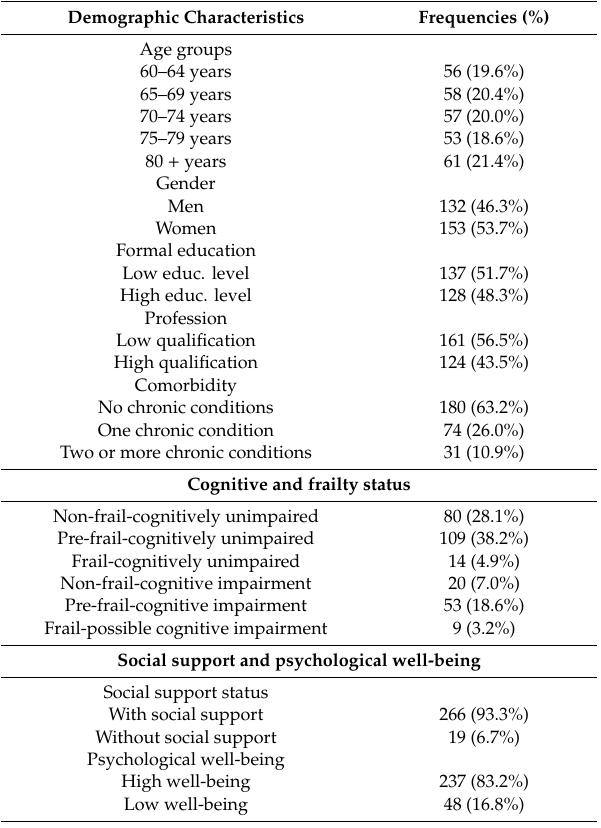
Table1. Demographicprofile, cognitiveandphysicalstatus, socialsupport, andpsychologicalwell-being.